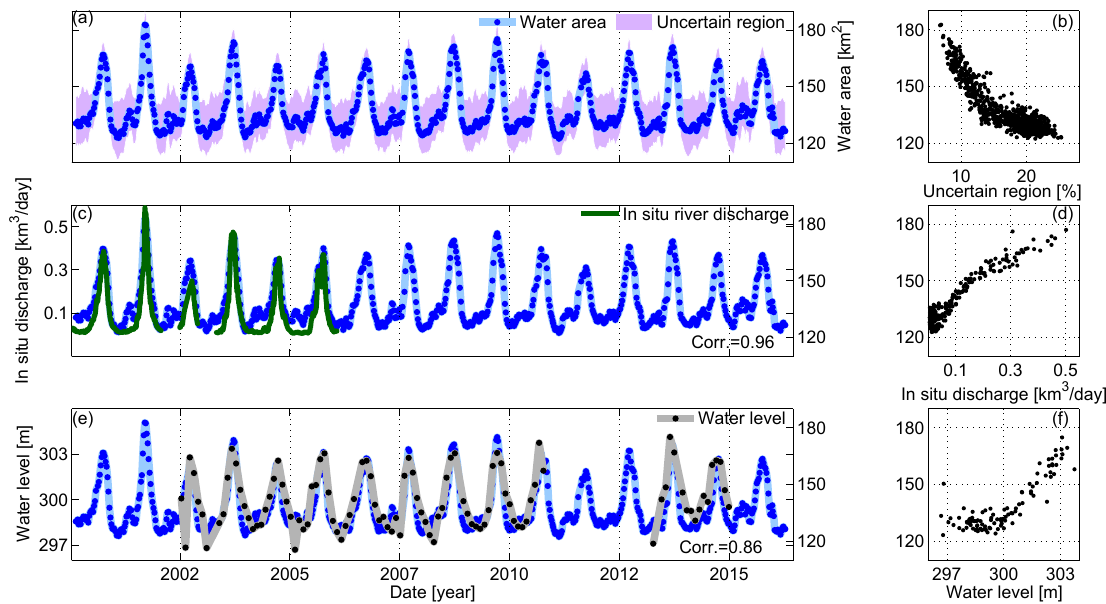
Figure 20. ( a – f ): ( a ) Water area with the uncertainty; ( b ) Scatter plot of water area vs. percentage of uncertainty; ( c , e ) Water area is plotted with in situ discharge and altimetric water level, respectively; ( d , f ) Scatter plots of simultaneous water area measurements against discharge and water level, respectively. Period of monitoring: February 2000–February